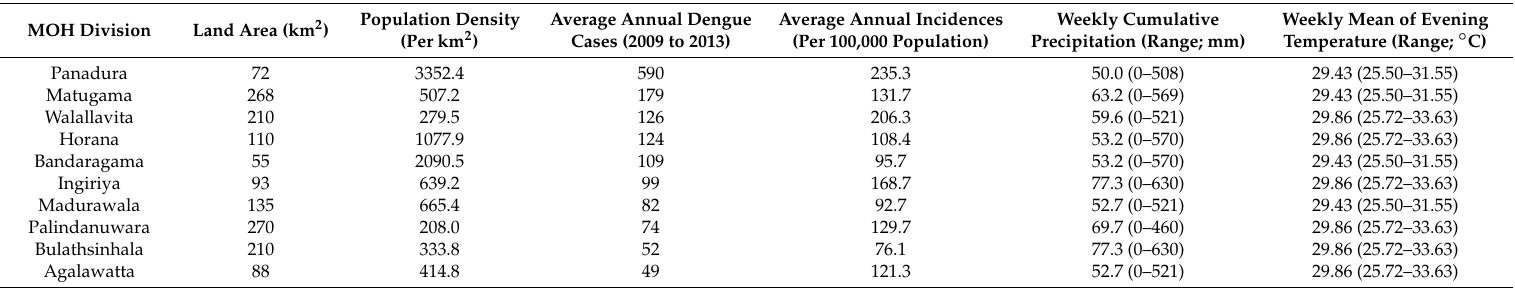
Table 1. Descriptive statistics of the study variables per MOH division over the study